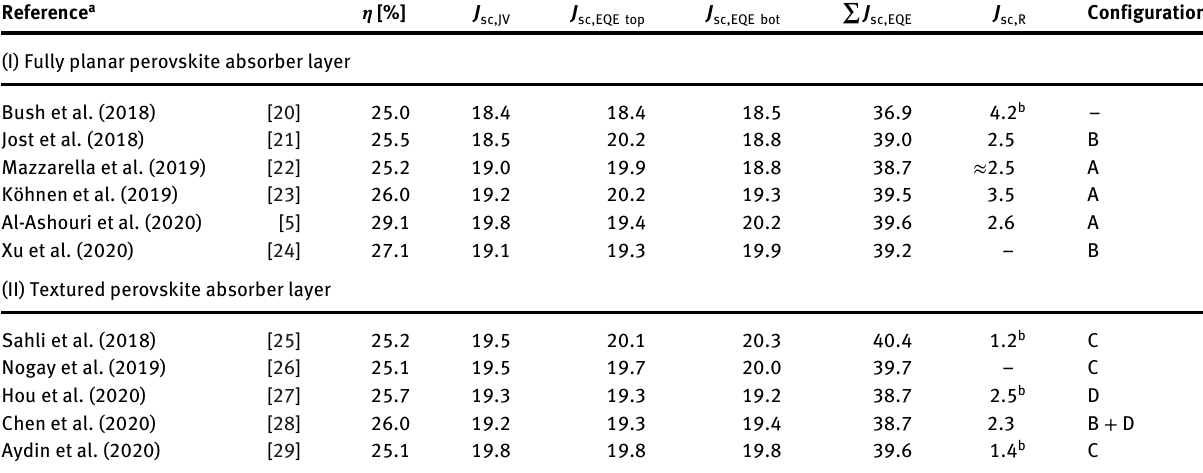
Table 1: Summary of recent high-efficient monolithic perovskite/silicon tandem solar cells with PCE 𝜂 > 25 % and their light management interlayer, B a textured front foil at the air-glass interface, C a double-side textured strategies (see also Figure 1): A denotes a nc- SiO x perovskiteabsorberlayer,and D asingle-sidedtexturedperovskiteabsorber. J sc , JV denotestheshortcircuitcurrentdensity( J sc )asdetermined from JV -characteristics, J sc , EQEtop constitutes the J sc values as calculated from external quantum efficiency (EQE) data of perovskite top ∕ bot ∕ R and silicon bottom cell, as well as reflectance losses, respectively. All J sc values are given in mA/ cm 2